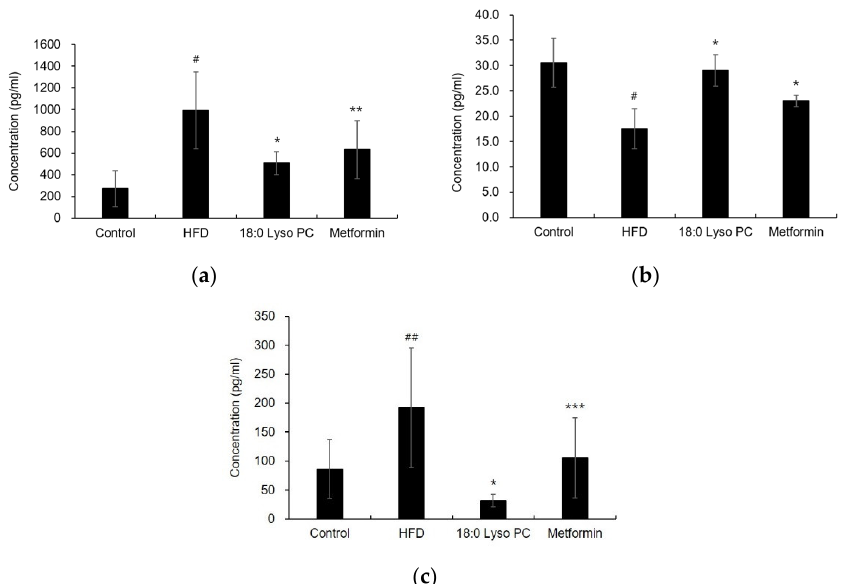
Figure 5. Effect of 18:0 Lyso PC on adipokines levels in serum of high-fat diet-fed mice. The concentrations of ( a ) leptin, ( b ) adiponectin, and ( c ) monocyte chemoattractant protein 1. The results are presented as mean ± SD ( n = 6). Significant differences were identified at # p < 0.005 and ## p < 0.05, the control group vs. the high-fat diet (HFD) group; * p < 0.005, ** p < 0.05, and *** p < 0.5, the HFD group vs. the treatment group.